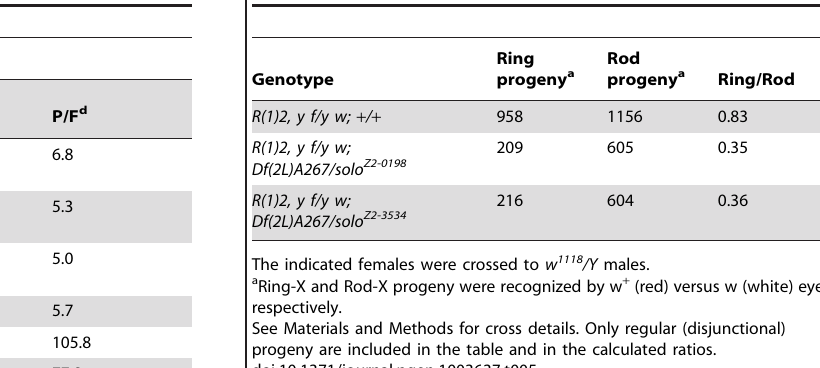
Table 4. 2 nd chromosome recombination in solo and control females.